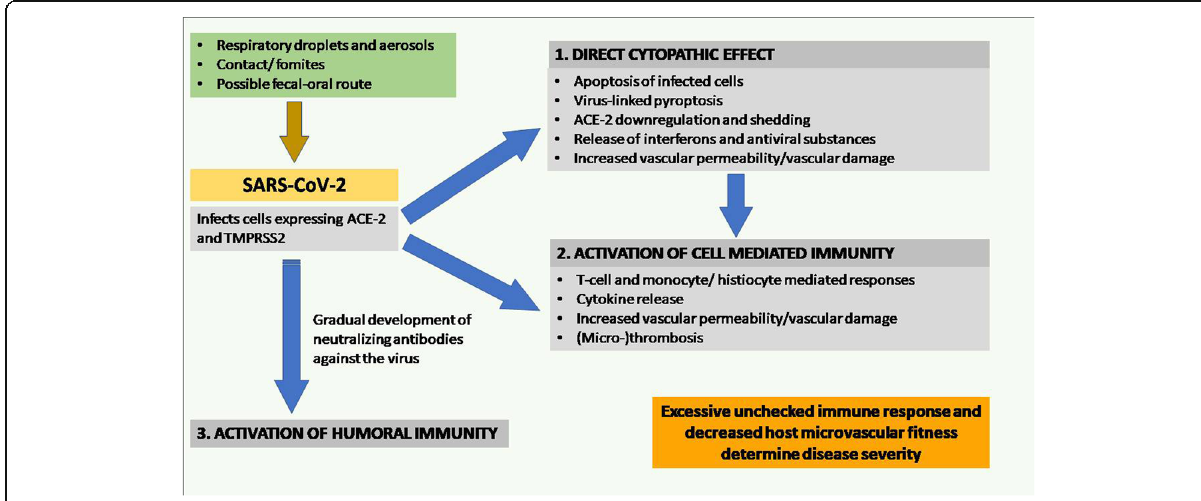
Fig. 2 Pathogenesis of